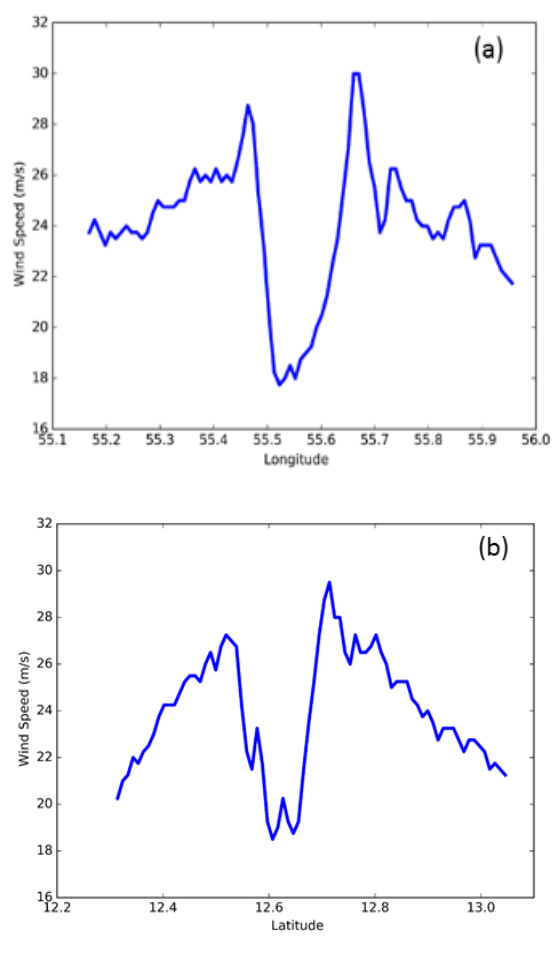
Figure 2. Variation of wind speed along a transect passing through the centre of the cyclone eye. (a) Along longitude and (b) Along latitude.